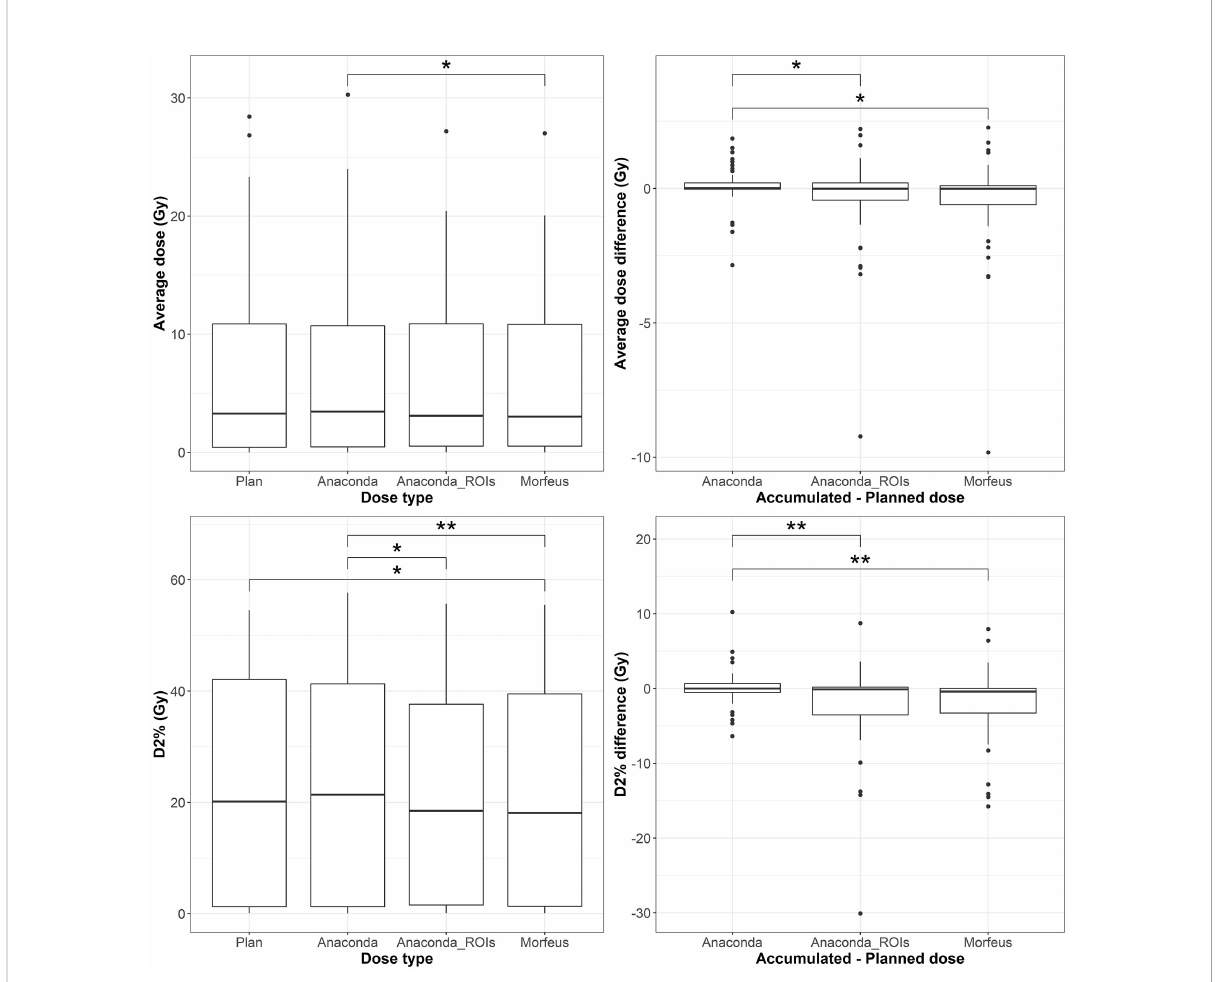
FIGURE 4 Left: average (top row) and maximum (bottow row) planned and accumulated Duodenum EQD2 (Gy). Right: difference between accumulated and planned doses. Statistically signi fi cant differences between means are indicated according to Bonferroni-adjusted p-values (*p <0.05; **p